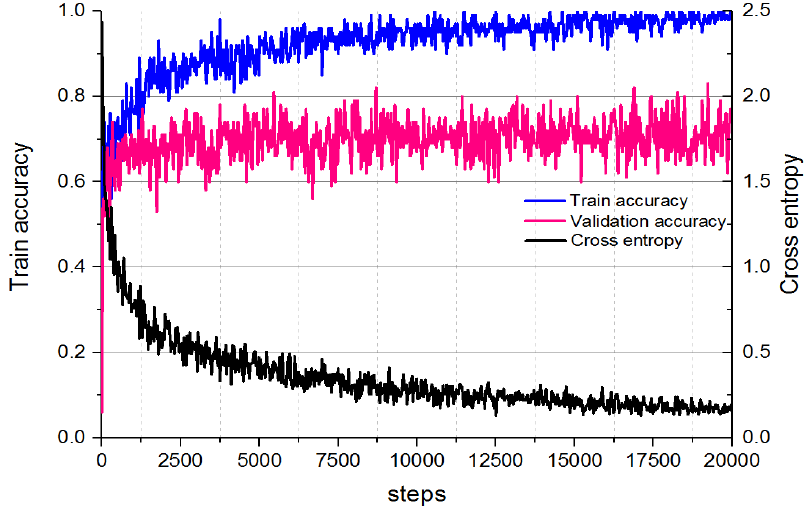
Figure 6. Training process with Inception-v3.